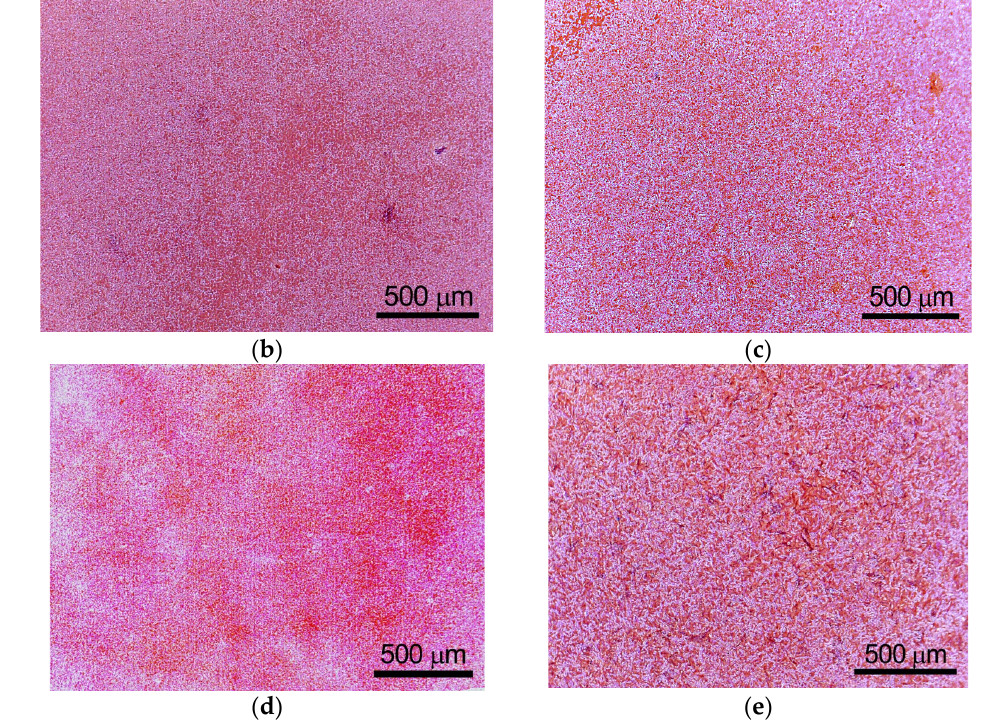
Figure 2. Optical micrographs of PLA ( a ) and composites PLA-TPP4OC 6 with TPP4OC 6 content, wt.%: 0.2 ( b ), 0.3 ( c ), 0.4 ( d ), and 0.5 ( e ).